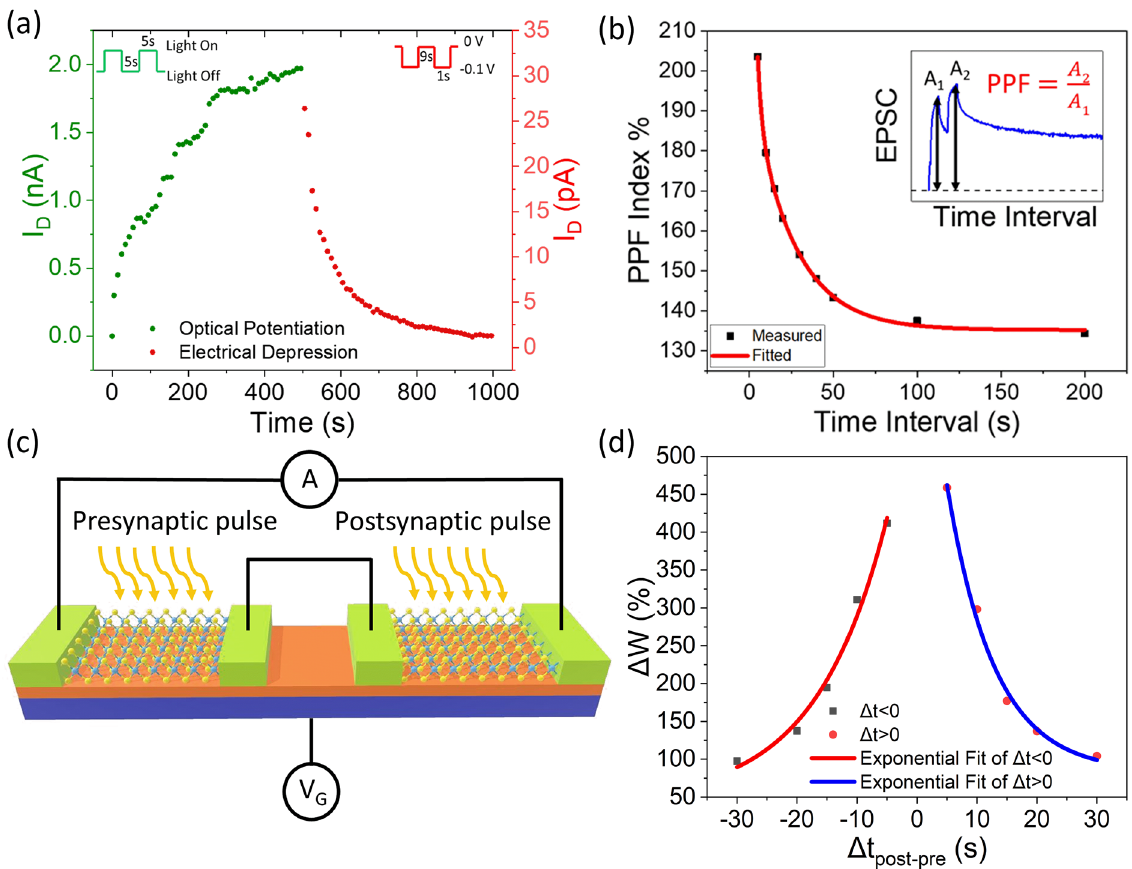
Figure 5. MoS 2 FET as optoelectronic synapse. ( a ) Optical potentiation by applying 50 light pulses (5 s on/5 s off) at V D = 1.0 V and electrical depression by applying 50 electrical pulses at the drain of amplitude − 0.1 V and duration 1 s in dark, V G = − 2 V is maintained throughout. ( b ) Excitatory post-synaptic current induced PPF index of the optoelectronic device with respect to time interval between two consecutive pulses measured at V D = 1.0 V and V G = − 2.0 V. Inset shows transient photocurrent of the device for applying two consecutive light pulses. ( c ) A schematic showing two connected optoelectronic synaptic devices for the emulation of